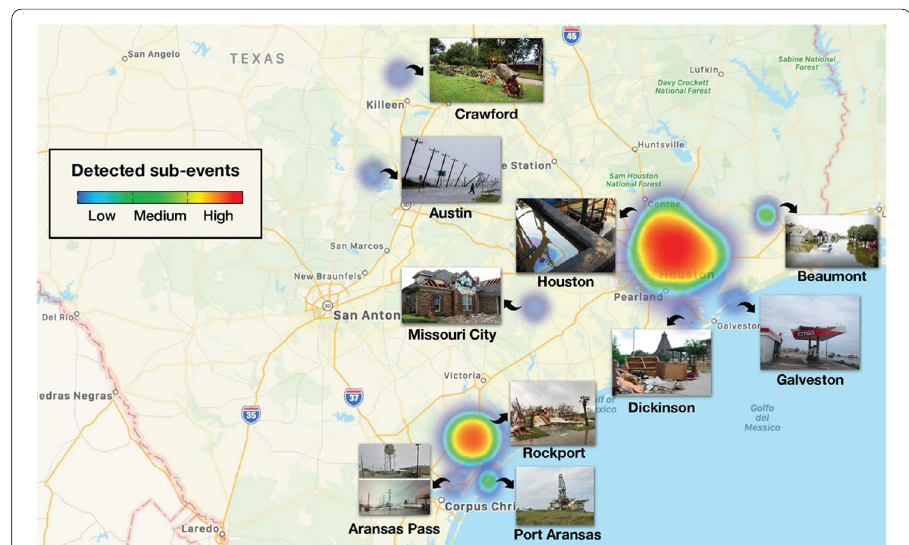
Fig. 9 Sub-events detected by SEDOM-DD using tweets collected after Hurricane Harvey